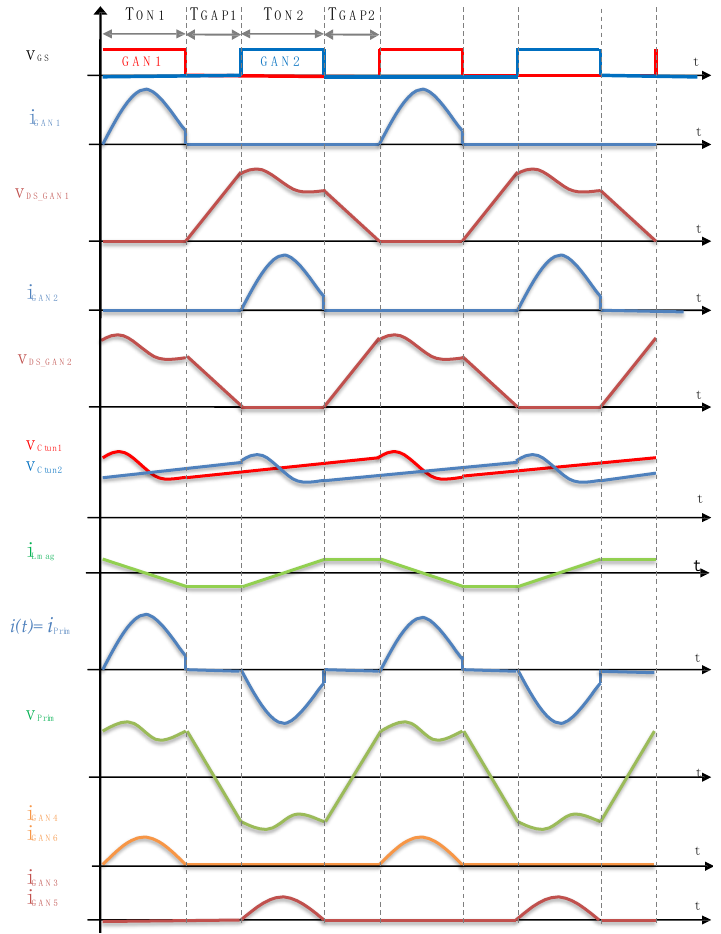
Figure 3. Theoretical time waveforms useful for the analysis of the ZVZCS resonant converter.